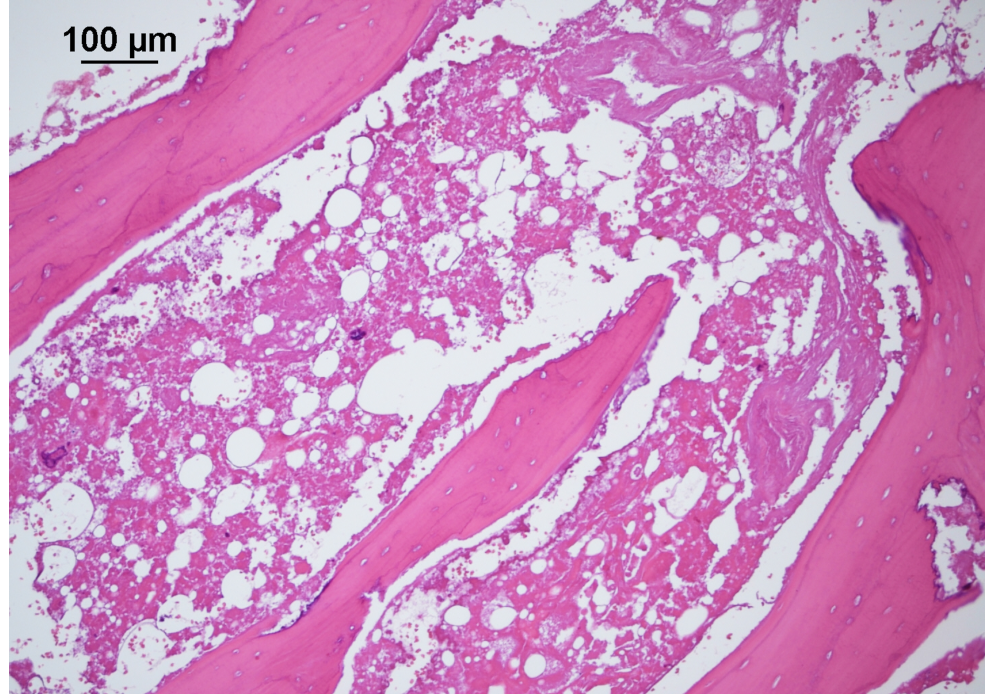
Figure 2. There is extensive necrosis of bony trabeculae and bone marrow tissue. No prominent inflammation is